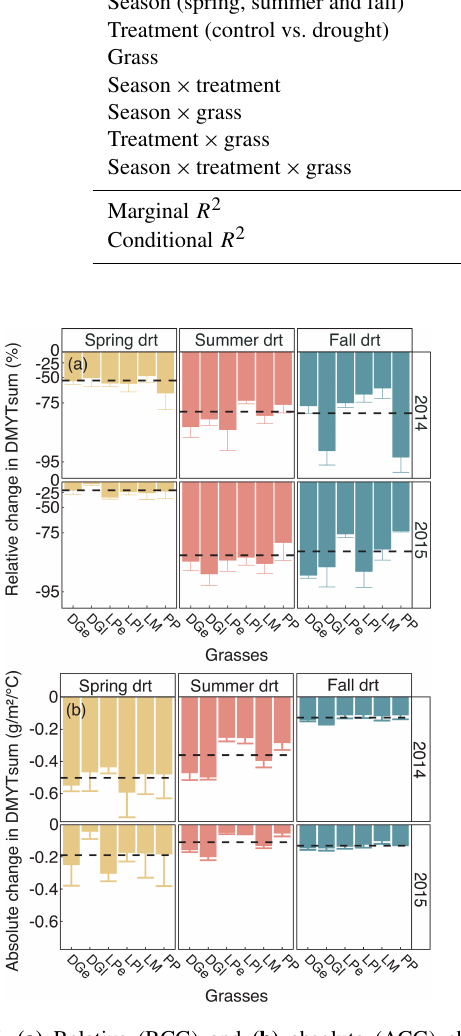
Figure 6. (a) Relative and (b) absolute changes in root dry matter at the end of each drought treatment and after 6 to 8 weeks after drought release in 2014. Values shown are means of four grasses of L. perenne (LPe and LPl) and D. glomerata (DGe and DGl), each in four replicates ( n = 4; ±